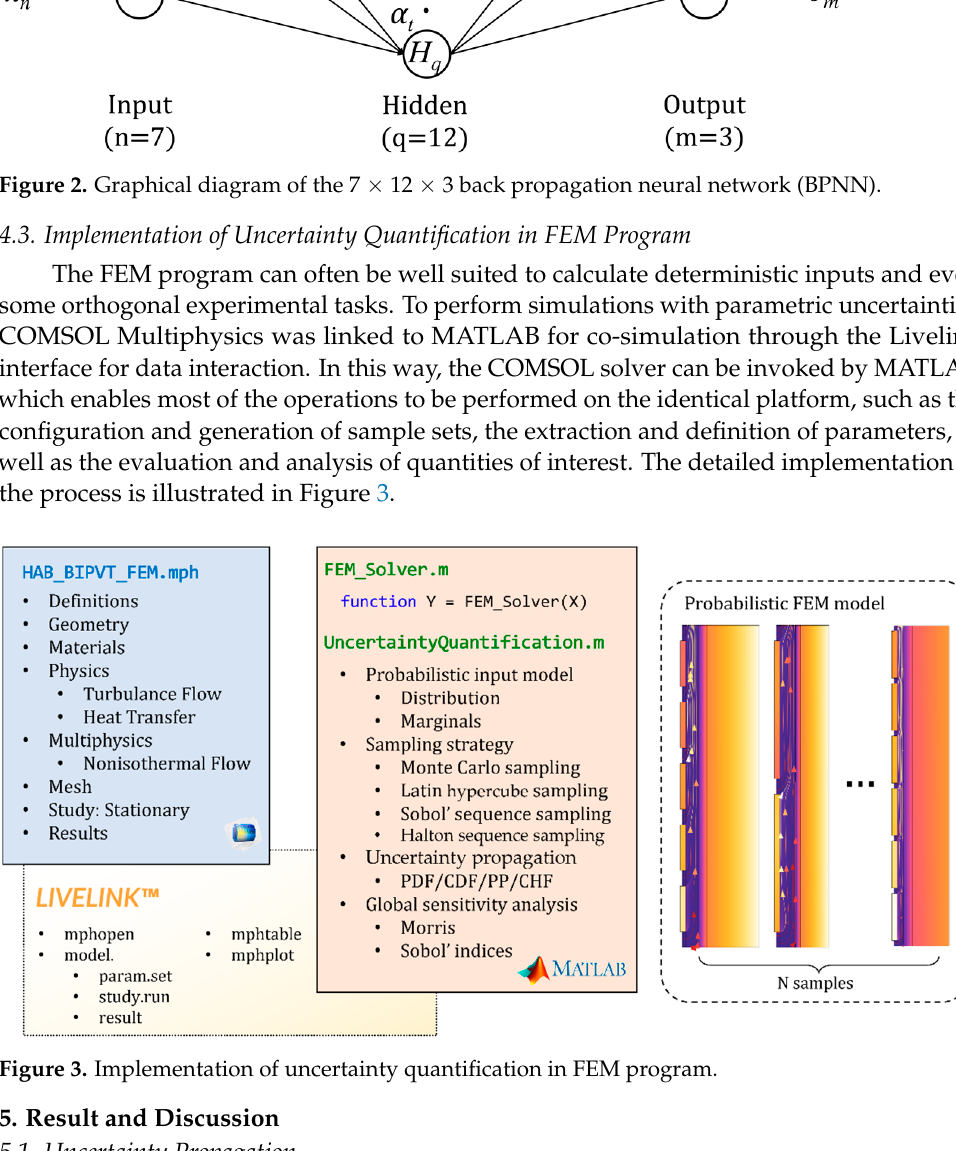
Figure 3. Implementation of uncertainty quantification in FEM program.